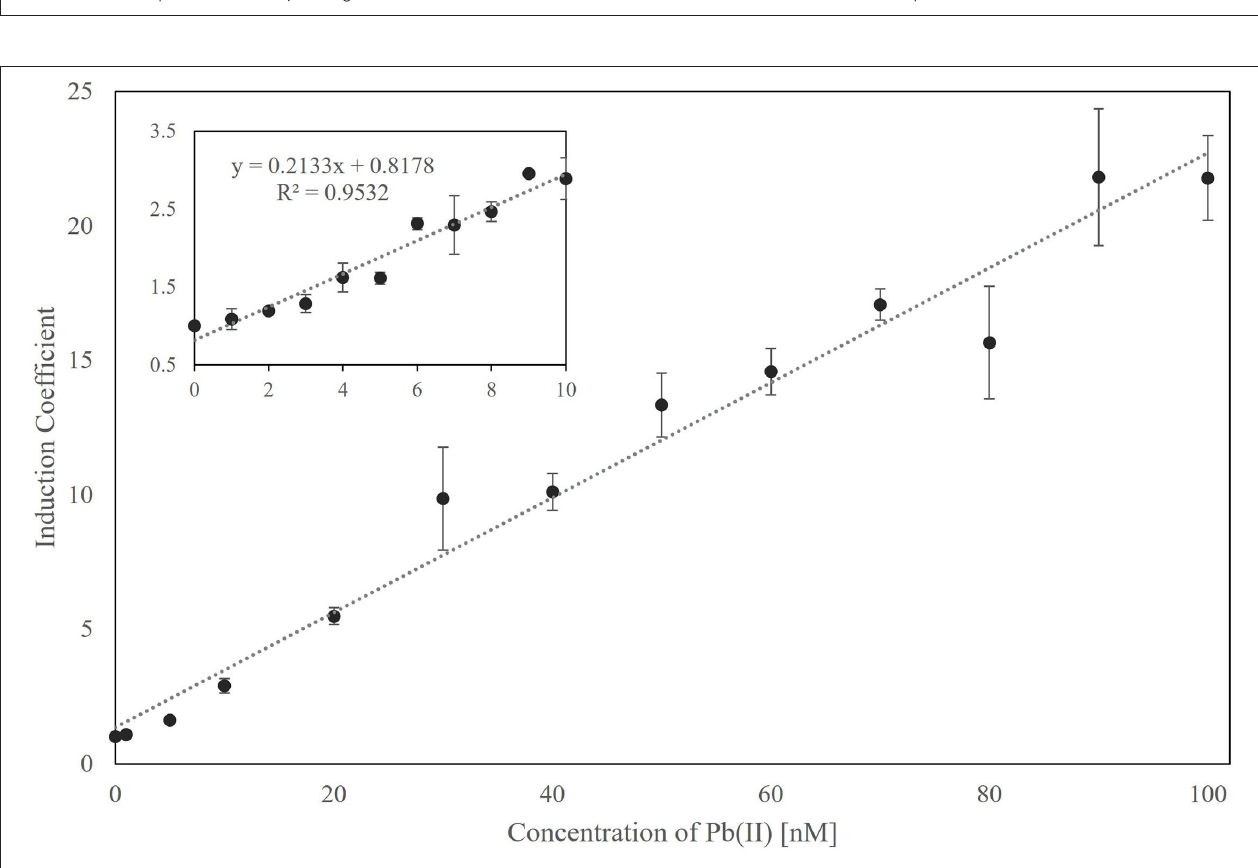
FIGURE 4 | The relationship between the responses of biosensors employing ZntR-C115I as a regulatory protein and Pb(II) concentration ranged from 0 to 100nM. The responses from 0 to 10nM of Pb(II) were shown in the inbox, and the relationship was analyzed by a linear regression fit with 0.953 of R 2 value.